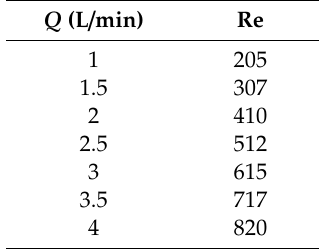
Table 2. Investigated values of the flow rate and corresponding Reynolds numbers (Re).